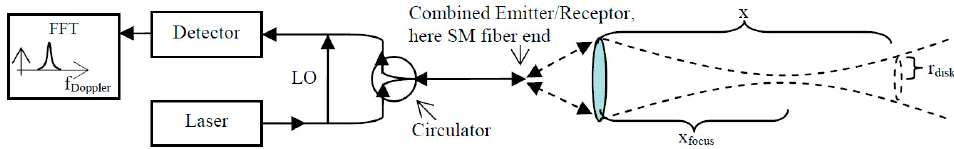
Figure 2. Schematic of focused monostatic CW coherent lidar based on fibre-optics components. Distance to focus is x focus , and distance to target scatterer is x; these are called f and L in Figure 1a. Reproduced from Lindelöw [4].